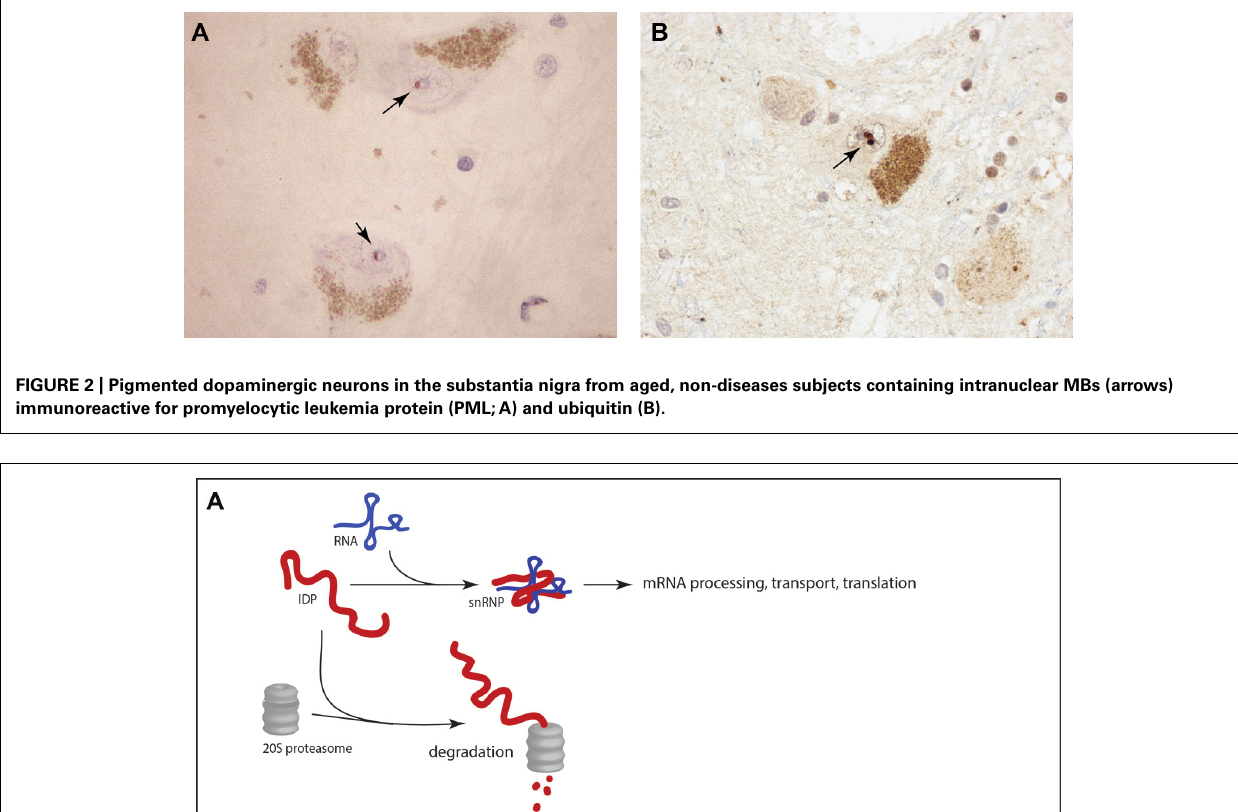
RNA-binding IDPs, which can promote aggregation and/or abnormalities in RNA metabolism.The potential exists for feedback loops of escalating dysfunction as abnormal IDPs are produced. If aggregates are not cleared by autophagy the potential also exists for the spread of dysfunction to other neurons through prion-like